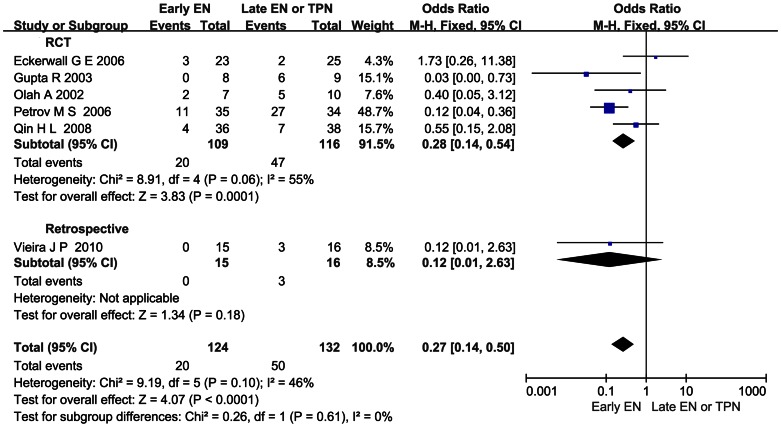
Forest plot showing the effect of early EN on the OF rate in AP.All the patients with OF were classified as pSAP or SAP previously. Fixed-effect model was applied and the sensitivity analysis subtotaling the plots by RCTs vs. retrospective studies was conducted.